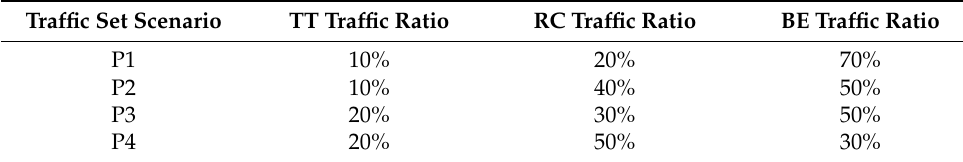
Table 3. The proportion of three types of traffic in different scenarios.